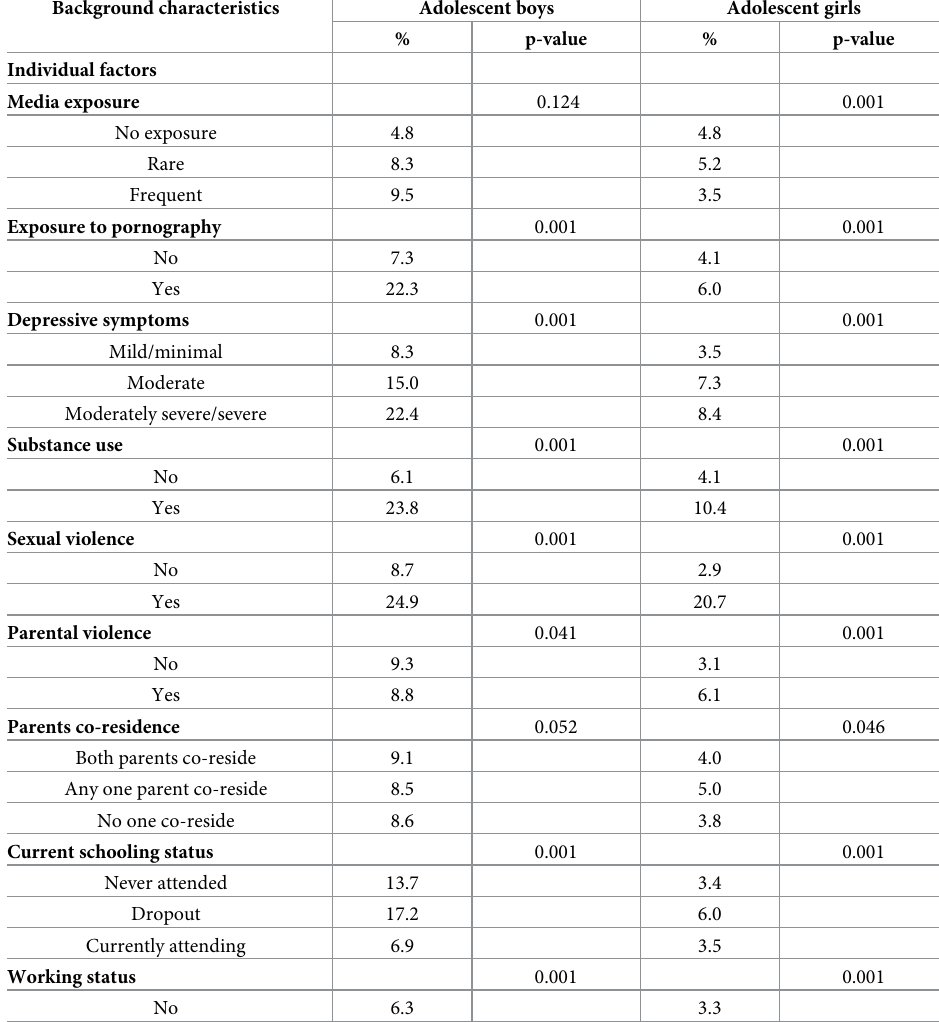
Table 2. Percentage distribution of unmarried adolescents who had early sexual debut by background